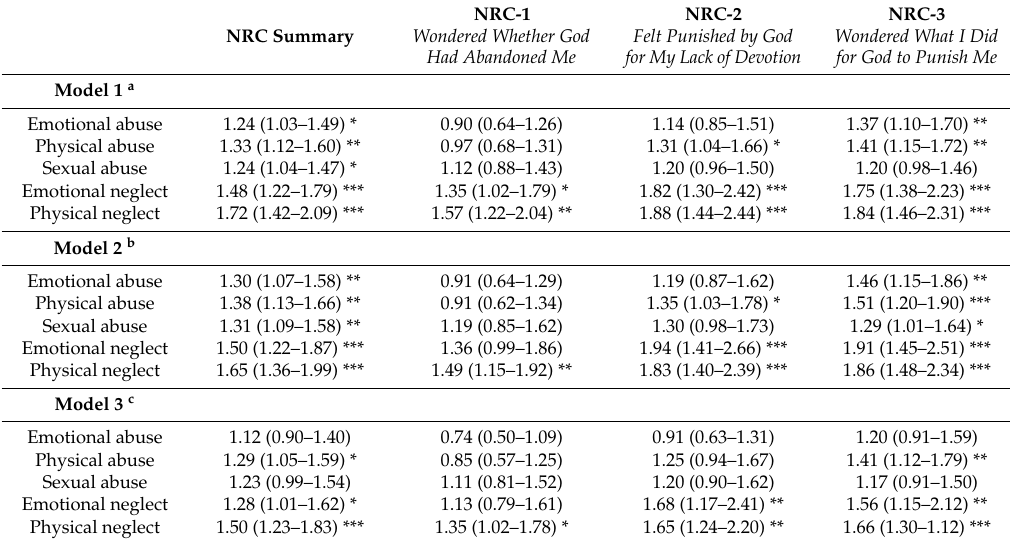
Table 3. Associations of childhood trauma experience with negative religious coping (summary and items) standardized to z-scores, crude, adjusted for age, gender, marital status, and education plus adjusted for raw anxiety and depression: results of binary logistic regression models leading to odds ratios (OR) with 95% confidence intervals (95%